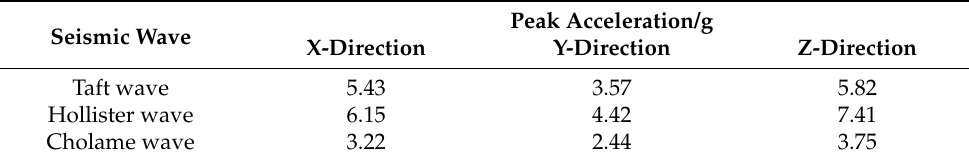
Table 9. Peak acceleration of center-hung